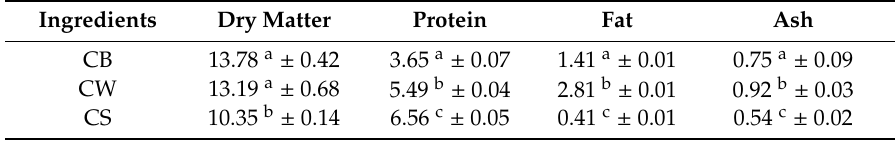
Table 1. Proximal composition of the di ff erent ingredients used for cheese production (% w / v ). Ingredients